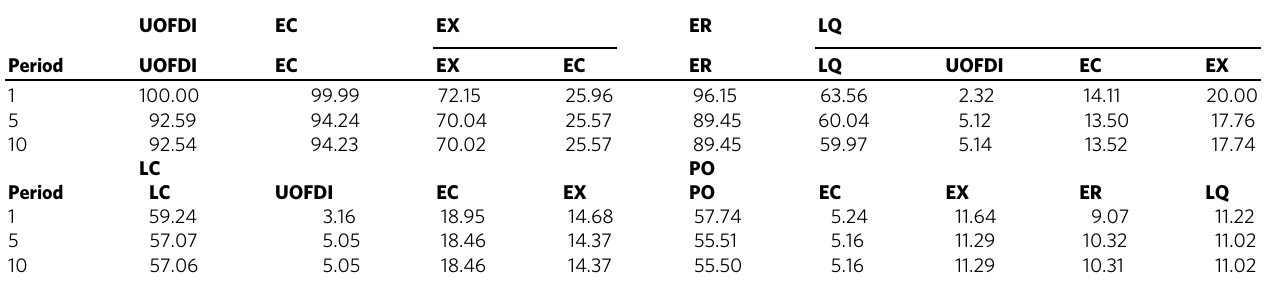
Table 12 Variance decomposition results